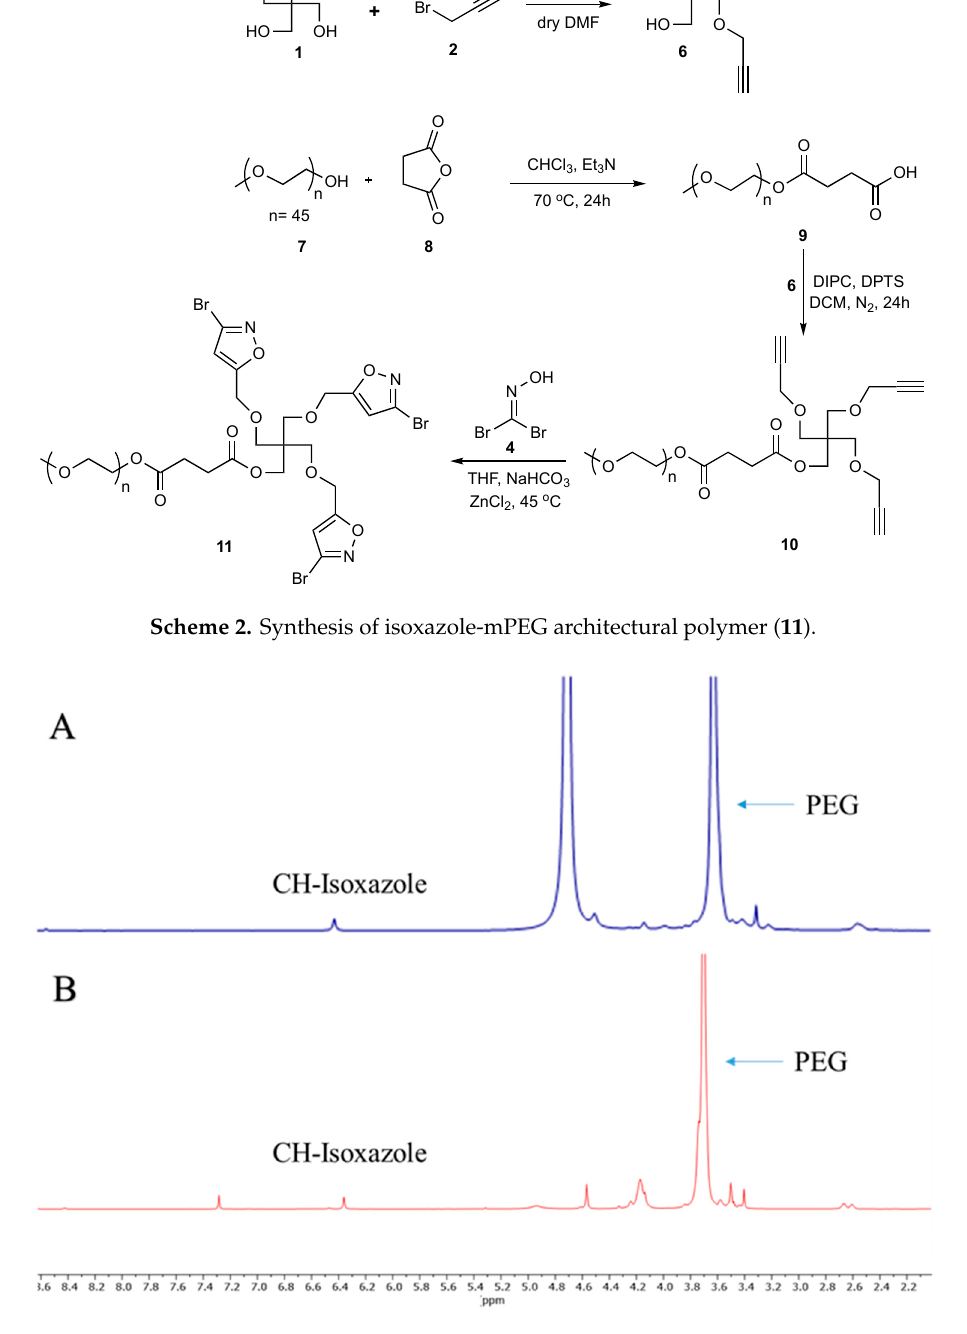
Figure 2. 1 H nuclear magnetic resonance (NMR) (500 MHz) spectrum of isoxazole telodendrimer in D 2 O ( A ) and CDCl 3 ( B ).